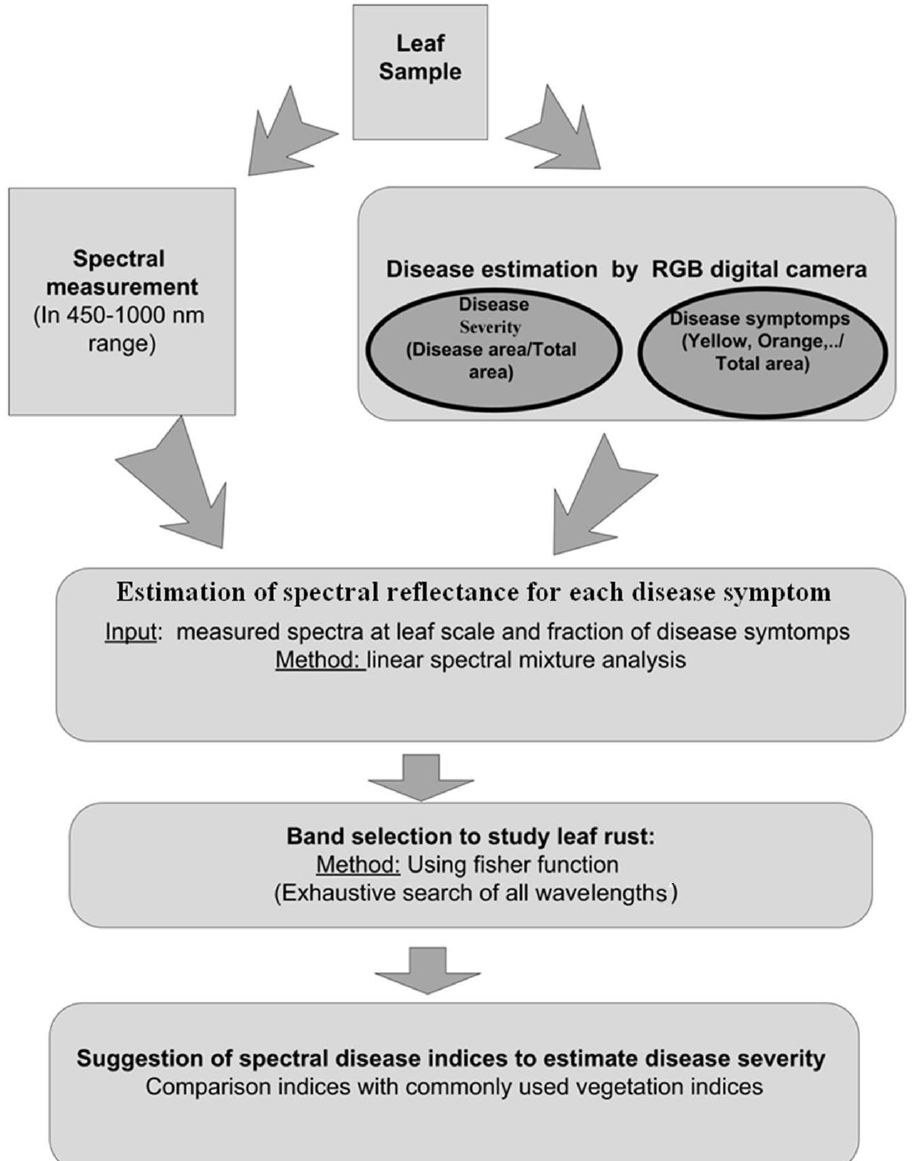
Figure 1. Flowchart for extraction of wheat leaf rust